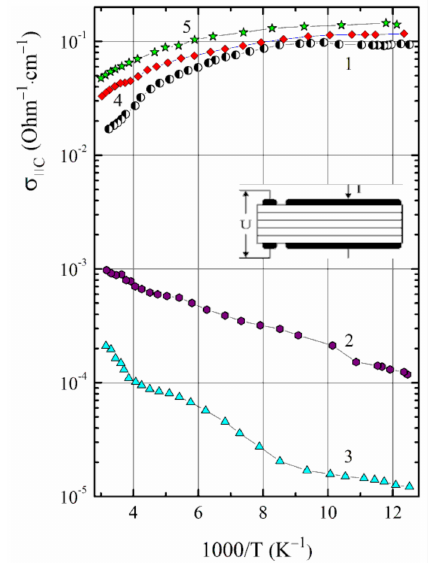
Figure 5. Temperature dependences of the transversal conductivity for the n -InSe samples: pristine (1), first-time and repeatedly intercalated with RbNO 3 (2 and 3, respectively), and annealed in vacuum (4 and 5, respectively). Inset shows the geometry of sample contacts for measurements of σ (cid:107) C .